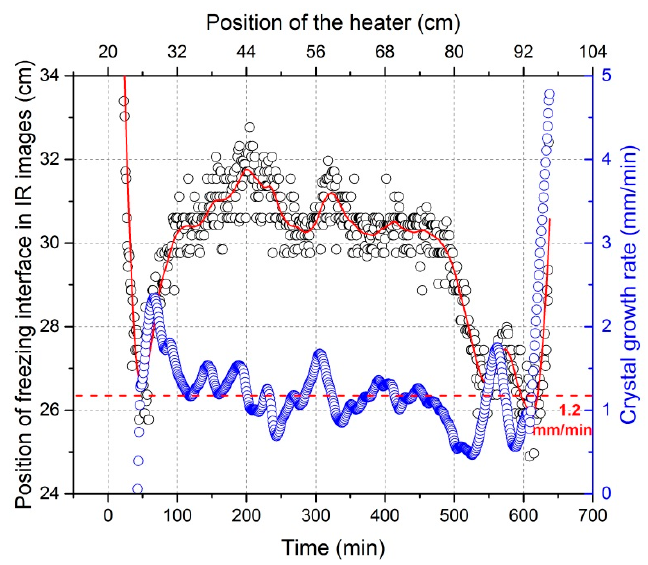
Figure 6. Variation in position of the freezing interface in thermographic images and the corresponding crystal growth rate against time in the case of moving the heating coil to the end of graphite crucible (the red dotted line represents the movement velocity of the heater).